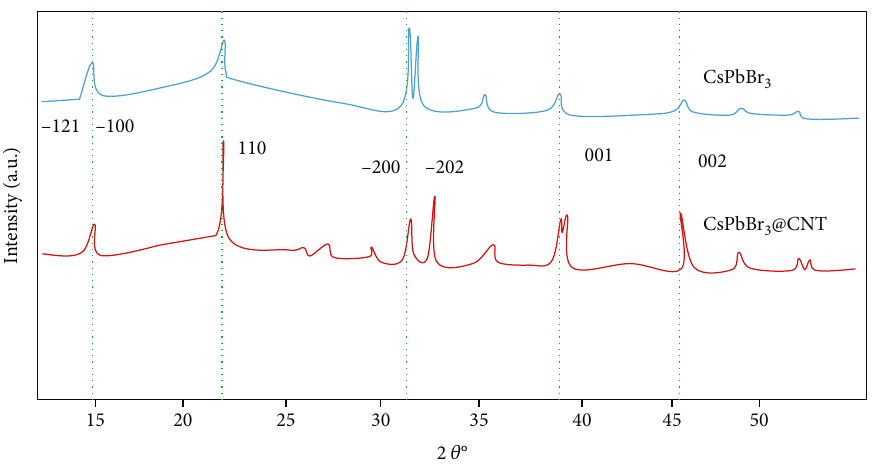
Figure 3: XRD patterns of CsPbBr3 and its composite CsPbBr3@CNT.